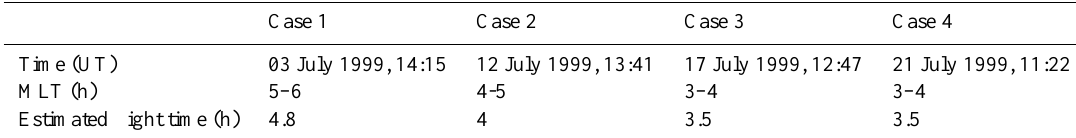
Table 3. The time of observation by Astrid-2, the MLT of the observed cloud and the estimated flight time between Astrid-2 and assumed source region of L = 10.